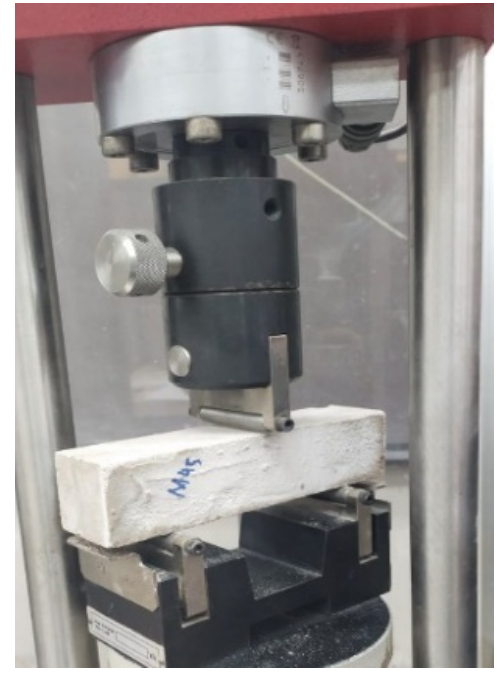
Figure 6. Test setup for flexural strength.